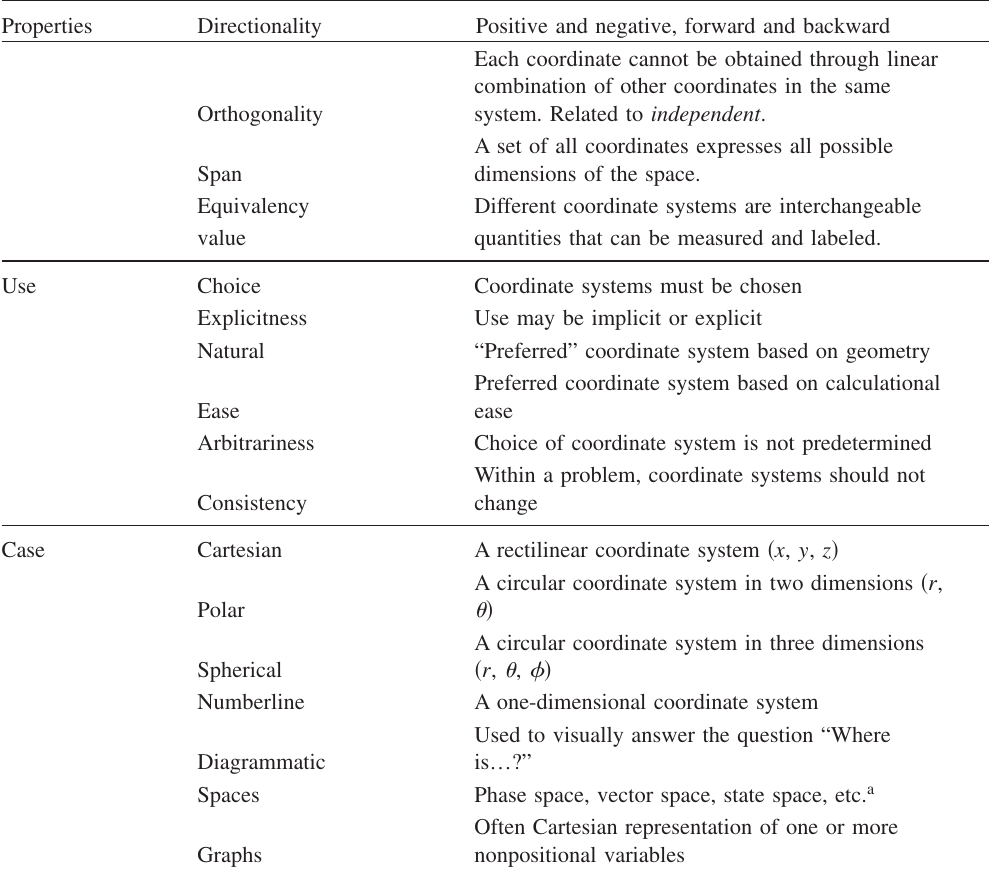
TABLE I. Subgraphs in coordinate systems. Each resource is described based on its application within coordinate systems. Noncoordinate system applications have more general